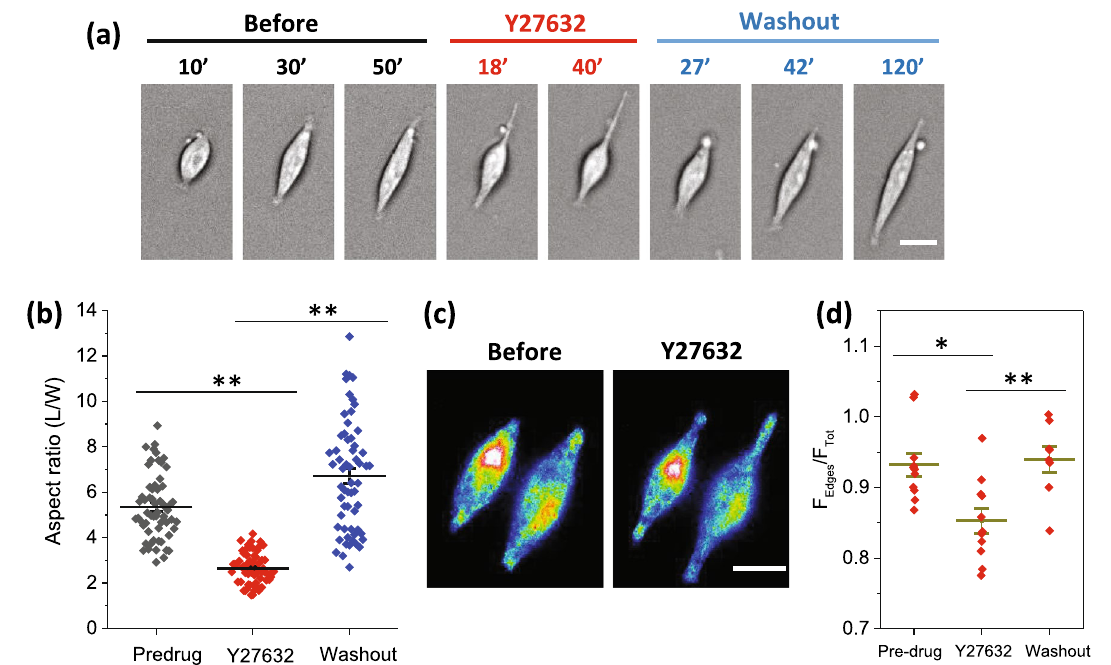
Figure 5. Effect of Rho-ROCK inhibitor on cell elongation. (a) Cell’s response to Rho-ROCK inhibitor Y27632 followed by washout, showing Y27632 reversibly inhibited cell elongation. The times measured from the beginning of each process, seeding, drug application, and washout, respectively. Scale bar represents 10 µm. (b) Mean aspect ratio for pre-drug treatment, 20 min after treatment, and 100 min after washout, shows that the drug effect is statistically significant (n = 60 for each condition from 6 experiments, * *p < 0.001). (c) GFP images of a typical HEK-hP1 cell before and after application of Y27632, showing Piezo1 proteins remained at the cell edges although the cell body contracted under the drug. Scale bars represent 10 µm. (d) Relative Piezo1 density in cell extensions in the presence of Y27632 is slightly lower compared with before and after washout (n = 11 for pre-and under drug, n = 8 for washout, *p < 0.01, ** p <